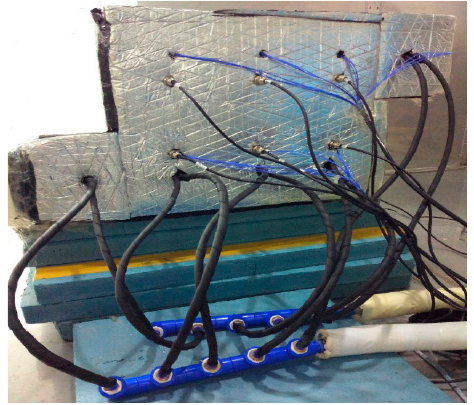
Figure 4. Image of the packed bed dehumidification system.